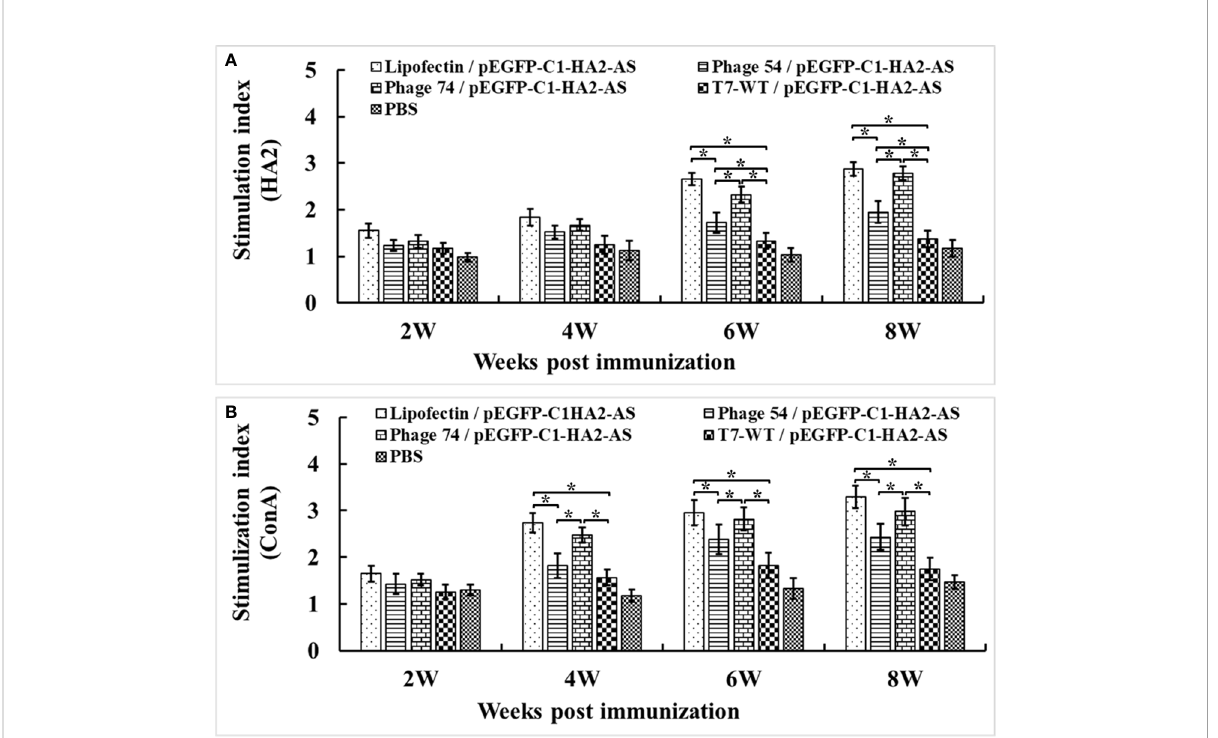
FIGURE 7 Peripheral blood lymphocytes (PBMCs) were prepared at 2, 4, 6 and 8 weeks post primary immunization and cultured with a truncated HA2 peptide and Con A (5 m g/mL). Lymphocyte proliferation was measured by cell counting kit-8 (CCK-8) reagent and shown as the stimulation index. (A) PBMCs stimulated by truncated HA2 peptide. (B) PBMCs stimulated by Con (A) Values represent mean ± S.D. (n = 3). * p < 0.05 was signi fi cantly